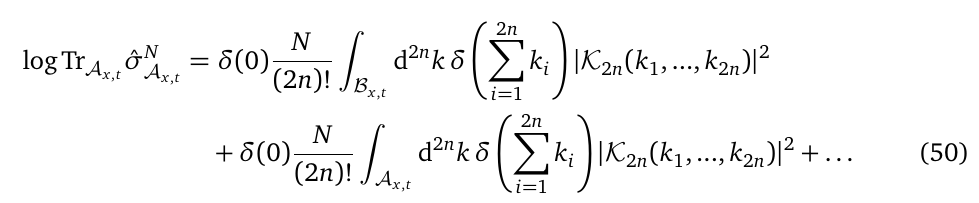
Figure 7: The connected Feynman diagrams contributing to Tr here depicted for N = 2. Panels ( a ) and ( b ) respectively represent the first and second line in Eq. (50): indeed, the internal arrows in Panel ( a ) are integrated over the B domain, while those in Panel ( b ) on the domain A x , t replica space allows to move the diagram across the replicas, resulting in an overall N factor. For example, in Panel ( a ) the diagram is drawn in the first region, but it can be put in the second one as well leading to the same contribution, thus accounting for a global factor